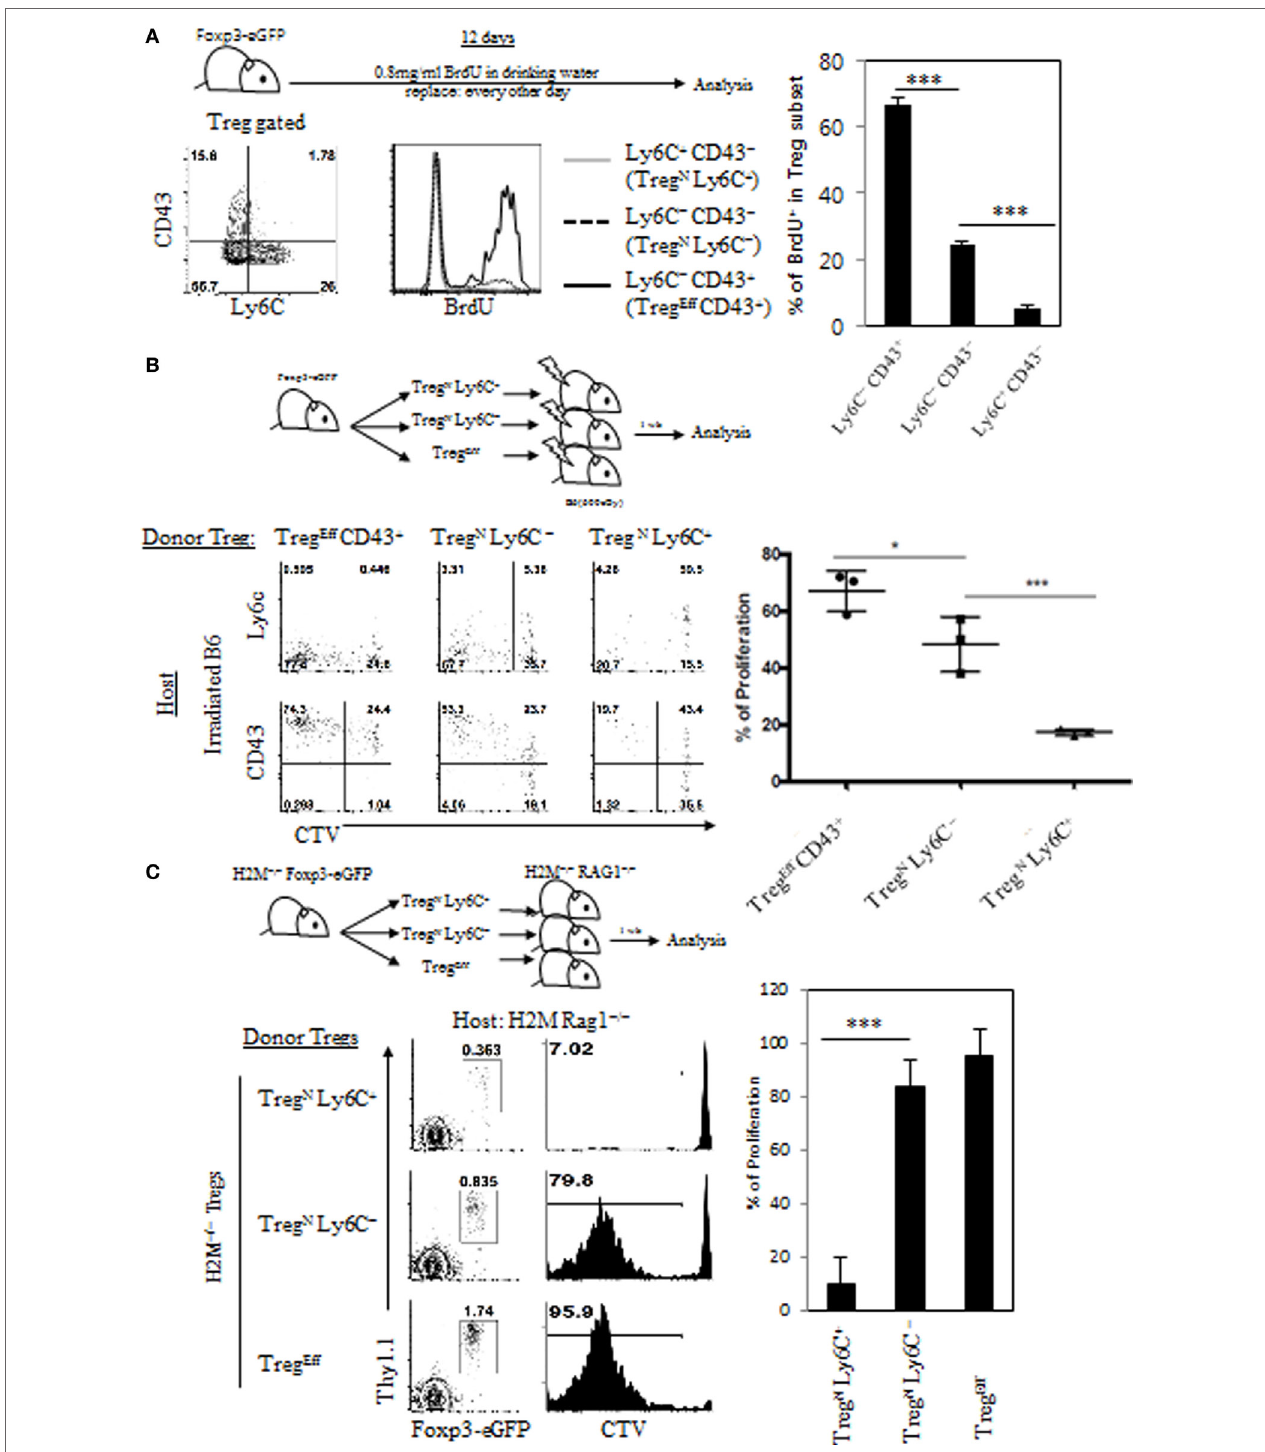
FigUre 3 | Poor responsiveness of Treg N Ly6C + subset to tonic T cell receptor stimuli. (a) Foxp3-eGFP mice were fed with 0.8 mg/ml of bromodeoxyuridine (BrdU) in drinking water for 10 days and then BrdU uptake levels on different subsets of T regulatory (Treg) were analyzed on day 10. Cell tracker violet-labeled Treg subsets from Thy1.1 + Foxp3-eGFP mice (B) or Thy1.1 + Foxp3-eGFP H2M − / − mice (c) were injected into irradiated B6 (B) or H2M − / − Rag1 − / − (c) hosts and then proliferations of donor Treg cells were analyzed on day 7 after transfer. The data are representative of three to four experiments comprising four to five mice per group. * p < 0.05, ** p < 0.01, and *** p <